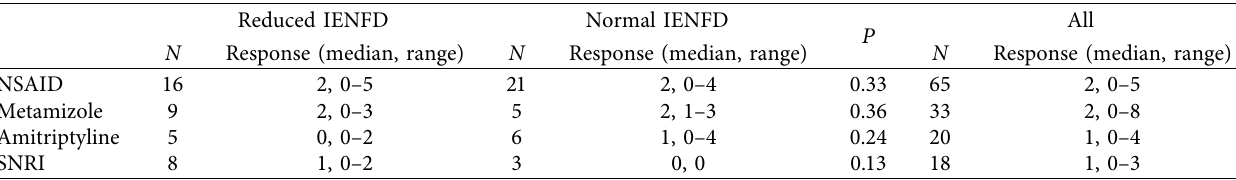
Table 4: Effect of the medication categories (current treatment) on pain relief in NRS-points, in the subgroups with and without reduction of skin